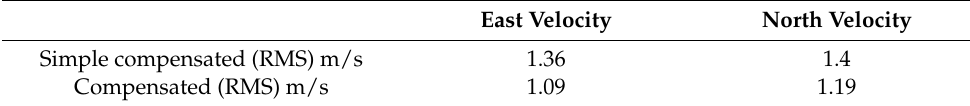
Table 7. Comparison of velocity error in flight experiment.